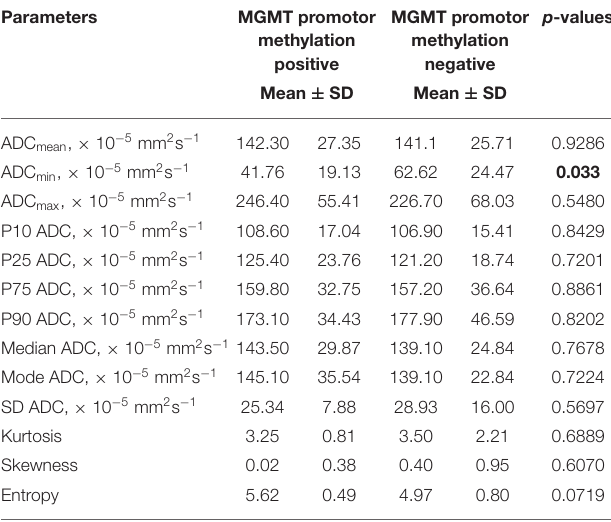
TABLE 3 | Comparison of DWI histogram profiles between low-grade gliomas with and without MGMT promotor methylation. Parameters MGMT promotor methylation